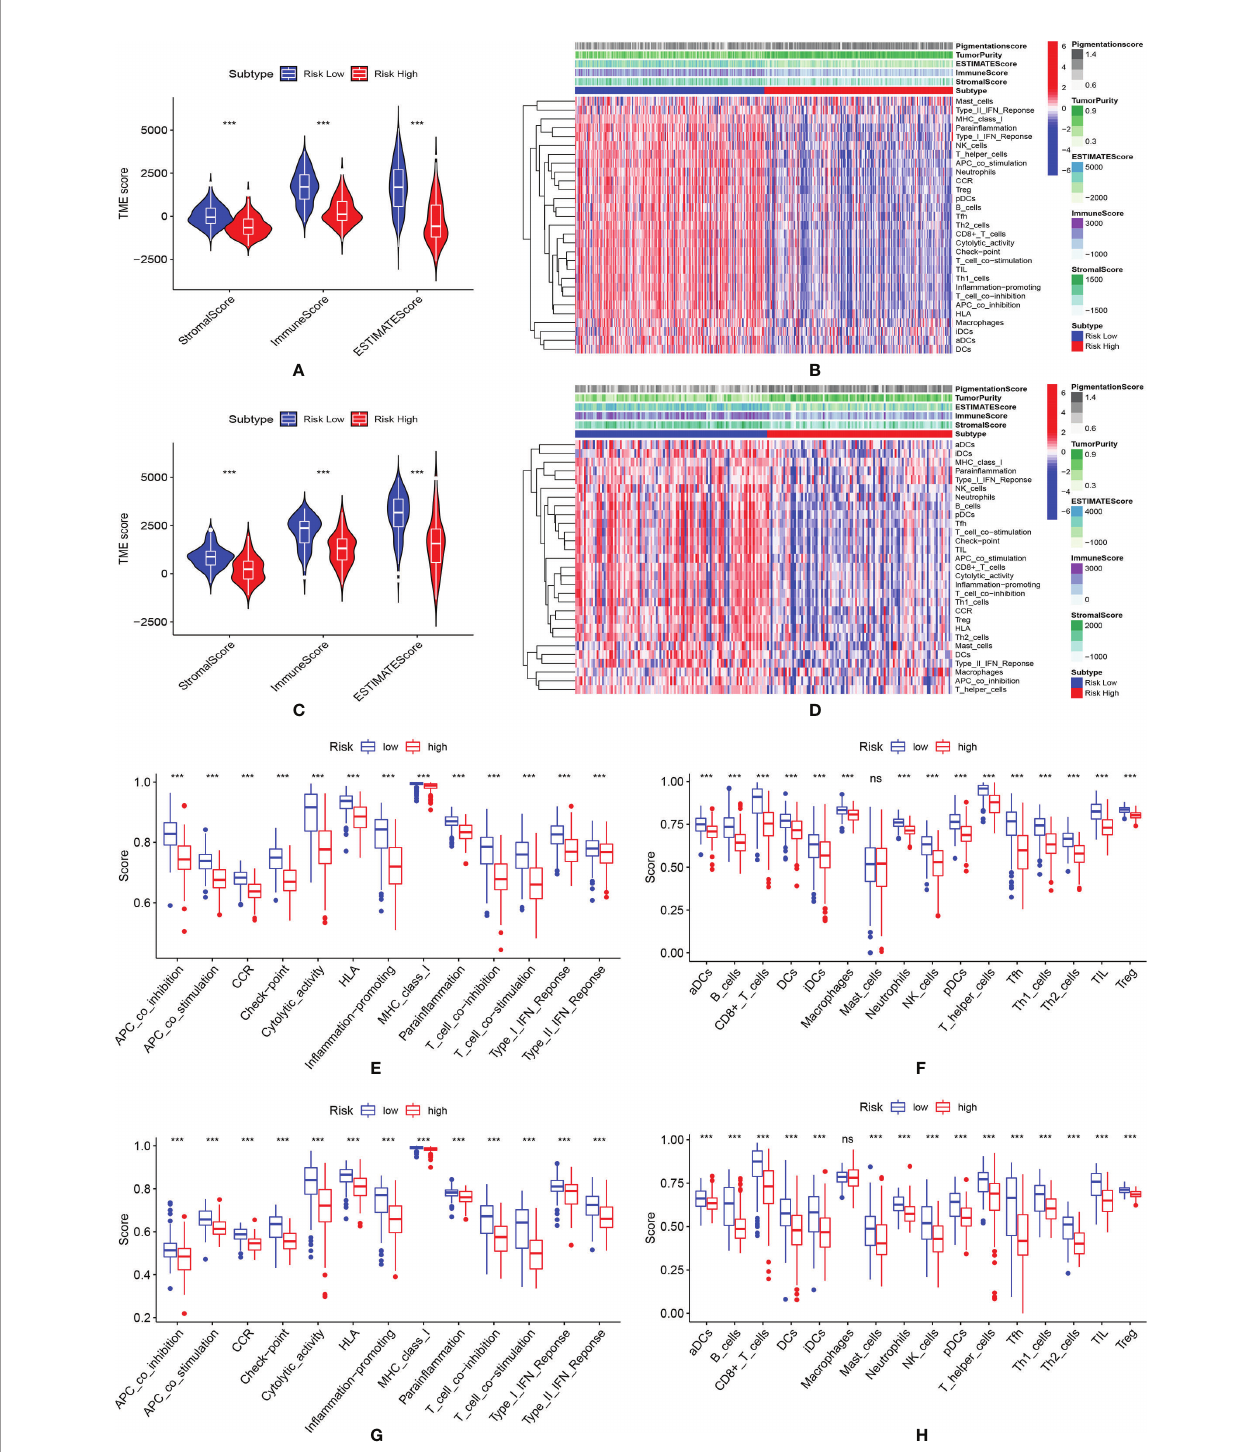
FIGURE 5 | Evaluation of tumor microenvironment. (A) The violin plot of the stromal score, immune score and ESTIMATEscore in the training cohort; (B) The immunity heatmap of high- and low-risk groups in the training cohort; (C) The violin plot of the stromal score, immune score and ESTIMATEscore; (D) The Immunity heatmap of high- and low-risk group in the GEO validation cohort; (E, F) Comparison of immune-related pathways and in fi ltration of immune cells between high- and low-risk group in the TCGA cohort; (G, H) Comparison of immune-related pathways and in fi ltration of immune cells between high- and low-risk group in the GEO validation cohort. *** means P < 0.001; ns, not signi fi